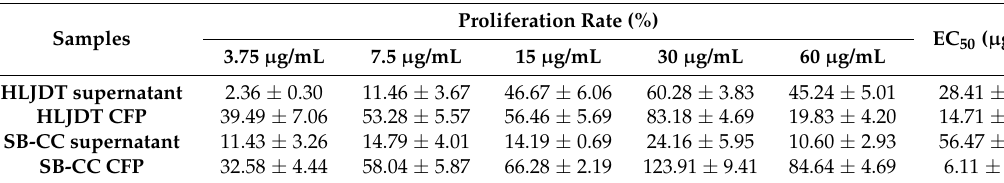
Table 5. The protective effect of HLJDT CFP, HLJDT supernatant, SB-CC CFP and SB-CC supernatant on PC12 cells injured by CoCl 2 (data are expressed as means ± SD from three separate experiments).